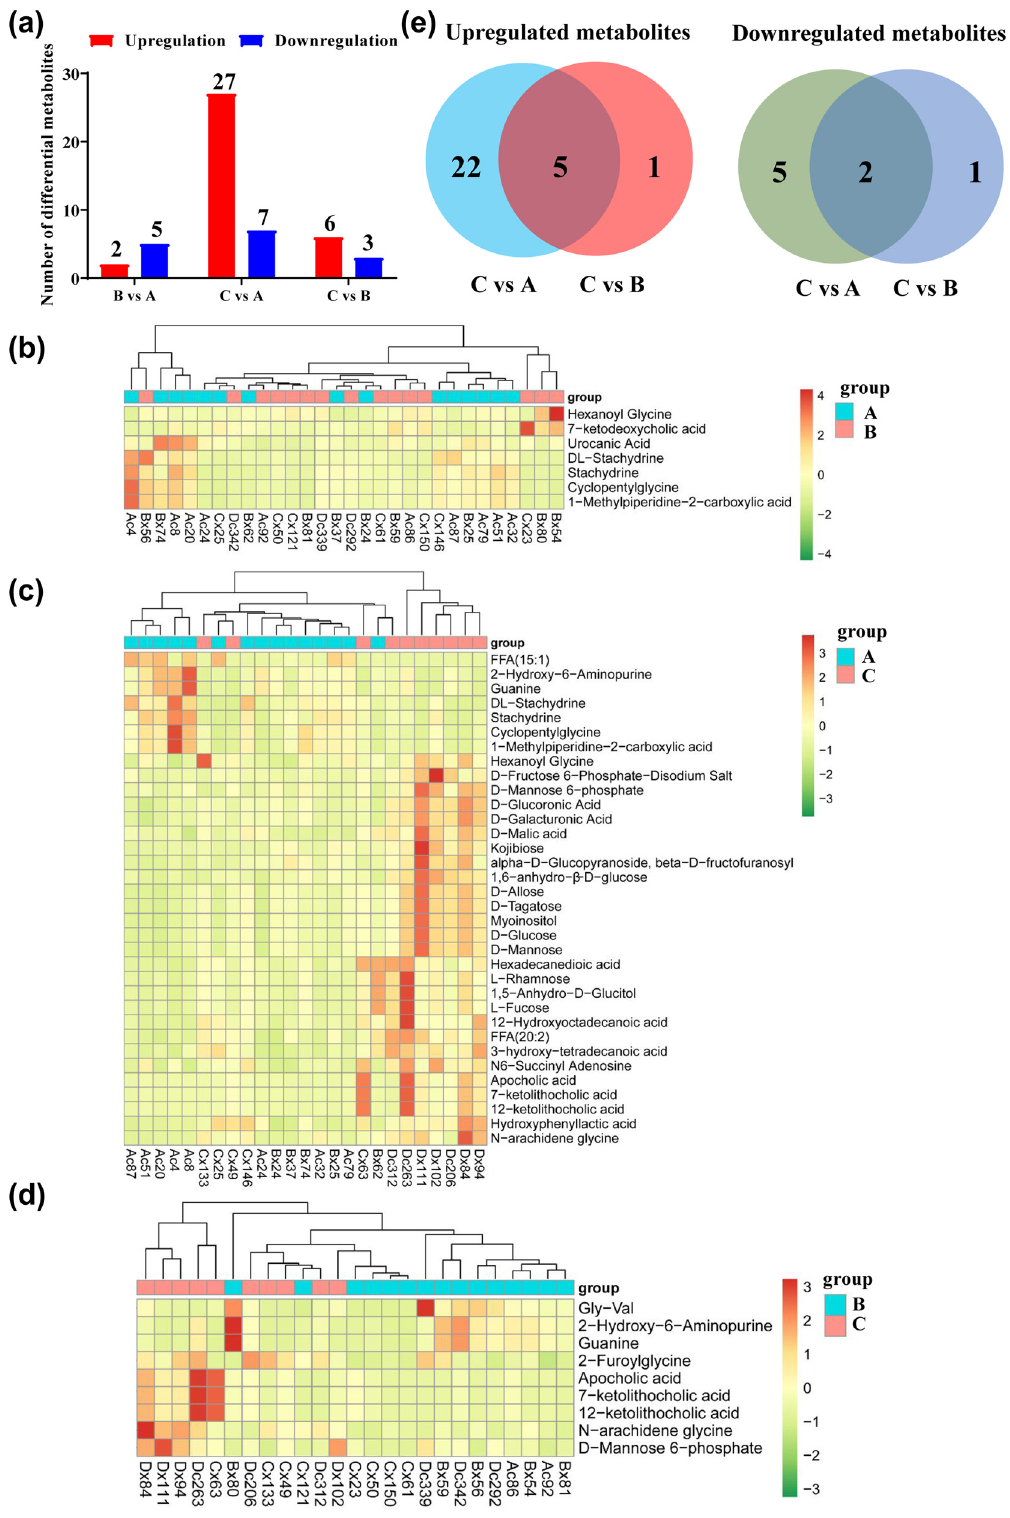
Figure 3: Analyses of di ff erential metabolites in people with di ff erent concentrations of vitamin D. ( a ) The number of di ff erentially upre - gulated and downregulated metabolites in B vs A, C vs A, and C vs B groups. ( b ) The heatmap of the metabolites in the B vs A group. ( c ) The heatmap of the metabolites in the C vs A group. ( d ) The heatmap of the metabolites in the C vs B group. ( e ) Venn diagram comparison of upregulated and downregulated metabolites between the C vs A and C vs B